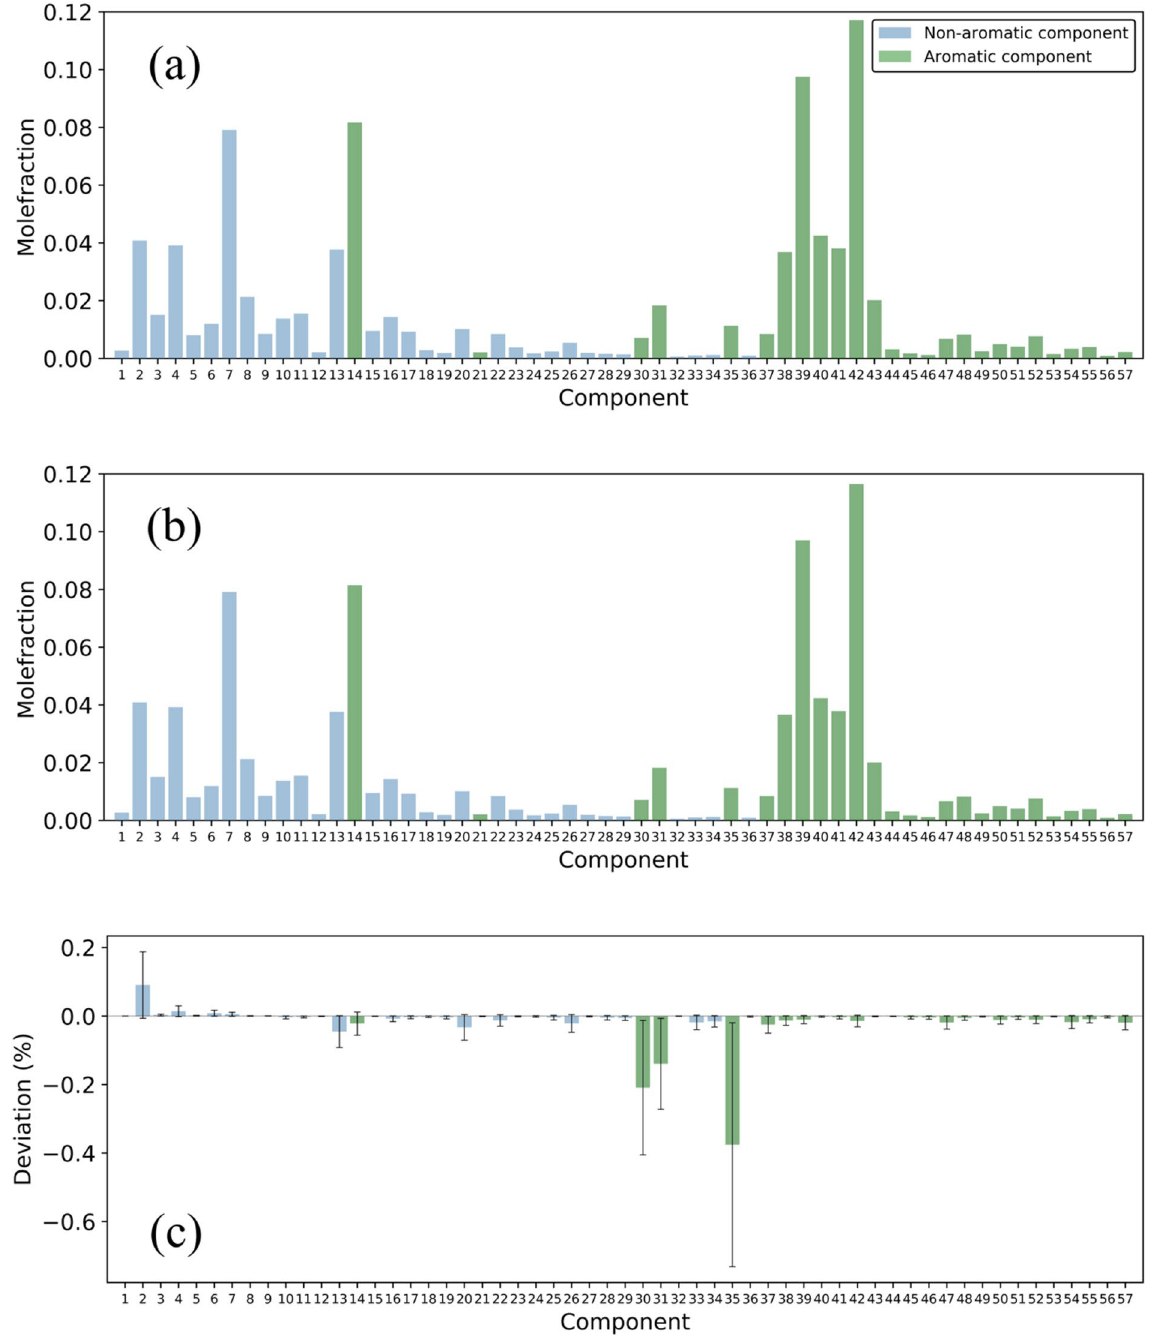
Figure 4. Back tracing of the initial composition of a 50% weathered sample using the ANN model. ( a ) the composition of an unweathered sample, ( b ) the initial composition of a 50% weathered sample estimated by the ANN, and ( c ) the deviation between the estimated composition and the actual composition. The names of the components can be found in the Supplementary Information. The error bars show the 95% confidence interval. The deviations for the oxygenated components (58, 59, 60) are less than 4% (not shown